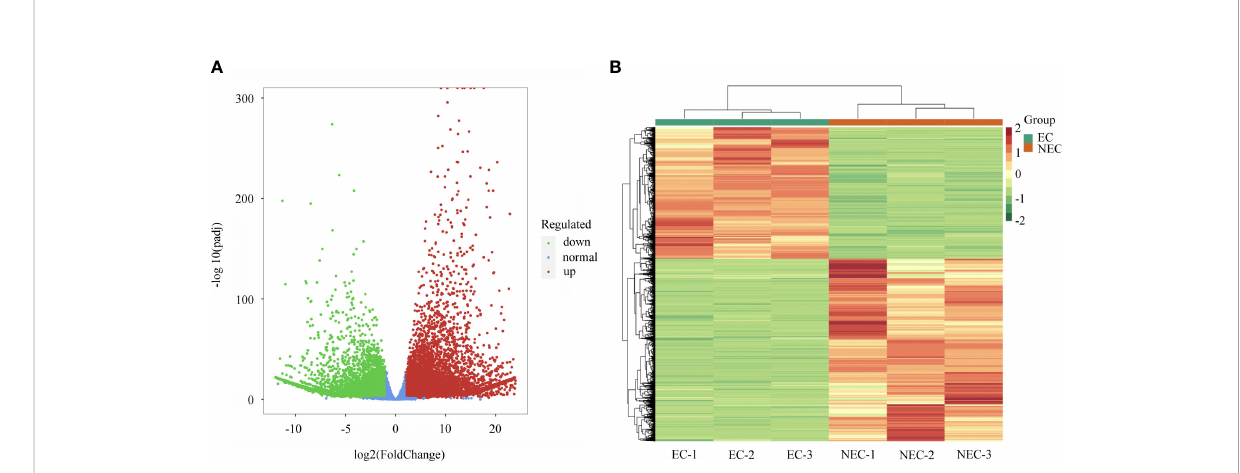
FIGURE 3 Analysis of differentially expressed genes (DEGs) between EC and NEC. (A) Volcano plot of DEGs between EC and NEC libraries, red and green dots represent the signi fi cantly upregulated and downregulated genes, respectively. (B) Heatmap of DEGs between EC and NEC libraries based on hierarchical clustering